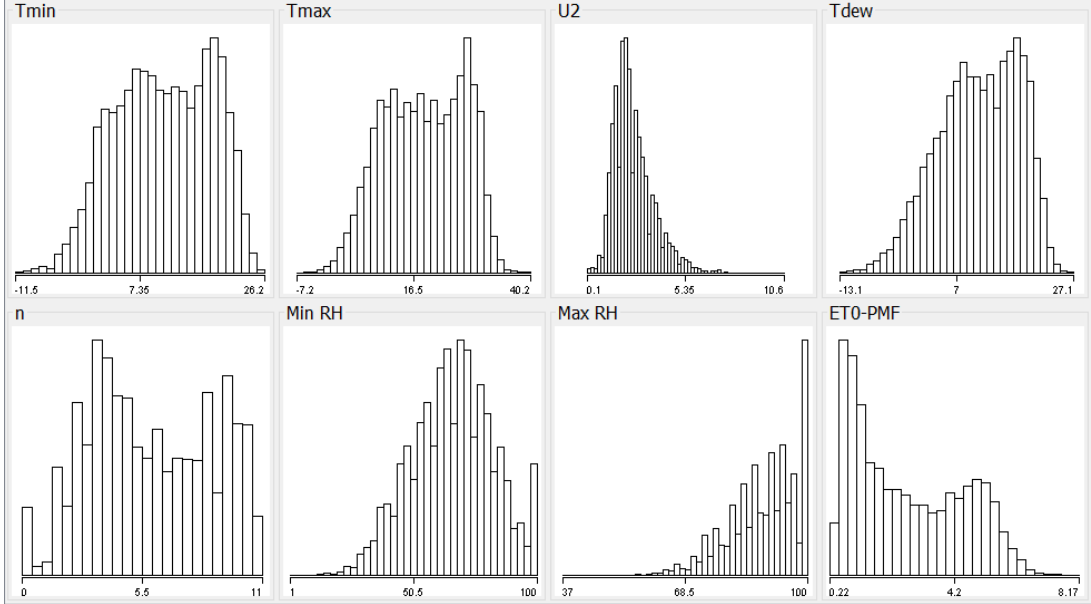
Figure 3. The distribution of the meteorological data used in the study.